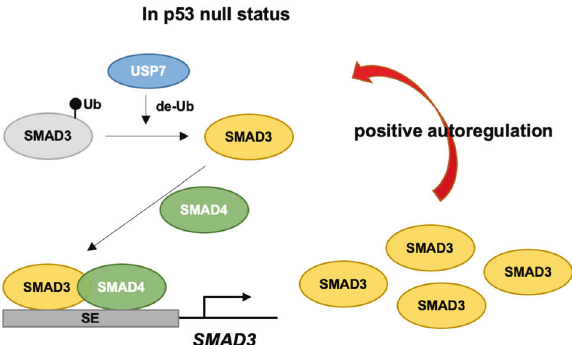
Fig. 8 Model for USP7 mediates the positive autoregulation of SMAD3 in p53-de fi cient lung cancer cells. Based on previous and our current results, the following working model for USP7-mediated autoregulation of SMAD3 is proposed: (i) the monoubiquitination of SMAD3 inhibits its interaction with coregulatory SMAD4 that impairs their DNA-binding function, (ii) the deubiquitinase function of USP7 directly catalyzes the removal of mono-ubiquitin from SMAD3, and (iii) the unmodi fi ed SMAD3 forms a heterodimer with SMAD4, binds to multiple SE constituents of SMAD3 locus, and enhances the expression of SMAD3 , (iv) upregulated SMAD3 facilitates its positive autoregulation and controls the cell cycle